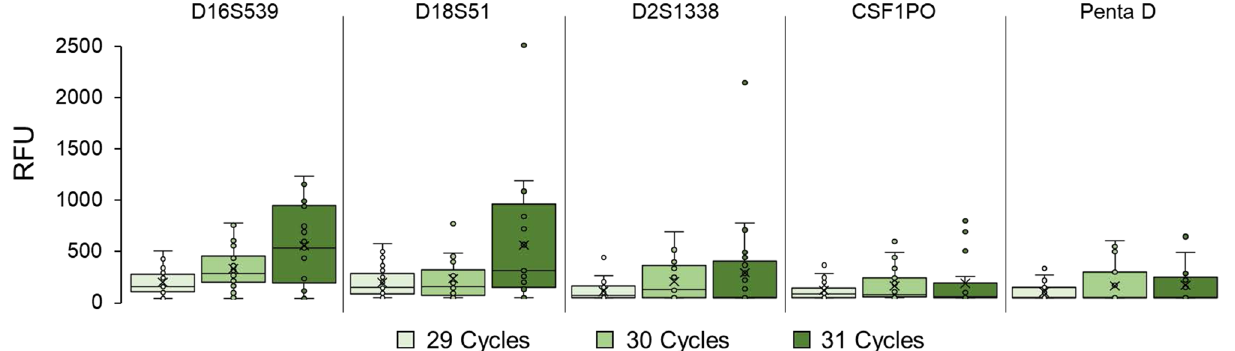
Figure 1. The distribution of locus-specific mean peak heights observed in 29, 30, and 31 cycle amplification groups in the green